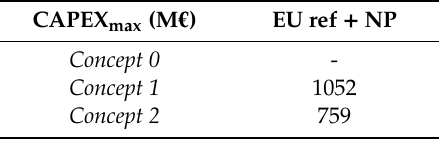
Table 3. CAPEX max for the different concepts selected (NP scenario).